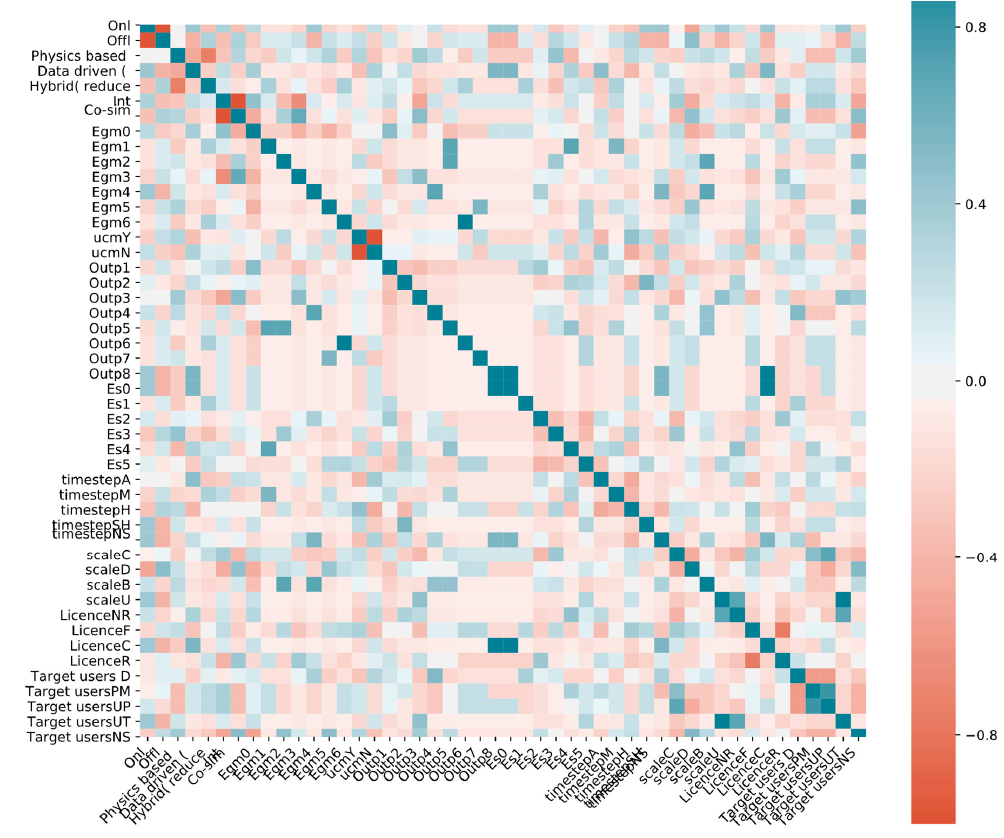
Figure 21. Pairwise correlation of UBEM capabilities. Colder colour indicates a capability consistently appearing together for tools.